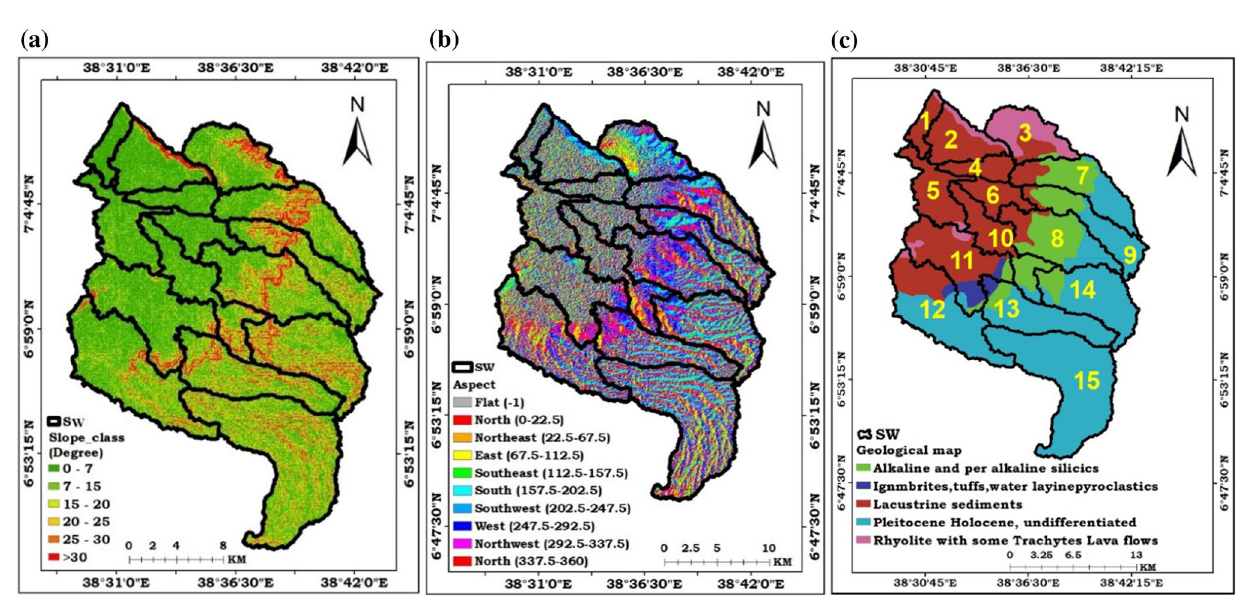
Fig. 7 Slope distribution ( a ) and aspect ( b ) and geological ( c )